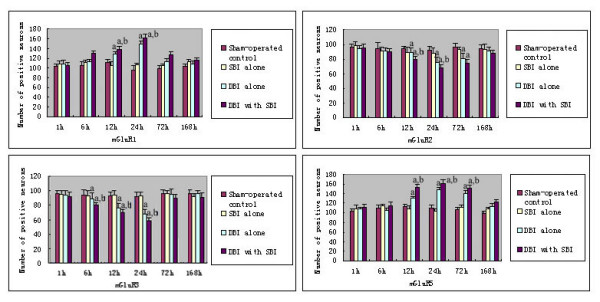
Changes of mRNA of Group I and II metabotropic glutamate receptors after diffuse brain injury and diffuse brain injury with secondary brain insults. Group I mGluRs The bar graph shows that there were no statistical differences in the number of group I and II mGluRs positive neurons among sham-operated control and SBI alone groups (P > 0.05). Compared with that of the sham-operated control and SBI alone groups, the number of group ImGluRs positive neurons increased at 12 hours and peaked at 24 hours in the DBI alone group (P < 0.05). And when compared with that in the DBI alone group, the number of group I mGluRs positive neurons increased significantly in the DBI with SBI group. In addition, the number of mGluR5 positive neurons remained higher until 72 hours (P < 0.05). In contrast to the expressing pattern of group I mGluRs, the number of mGluR2 positive neurons began to decrease 12 hours after injury and the lowest point occurred 24 hours after injury in the DBI alone group. The expression of mGluR3 significantly decreased 6 hours post-injuries and the lowest pointwas at 24 hours after injury (P < 0.05). In the DBI with SBI group, the changes in the number of mGluRs positive neurons were similar to that in the DBI alone group, but the number was much lower (P < 0.05). aP < 0.05 sham-operated control and SBI alone groups. bP < 0.05 vs DBI alone group.